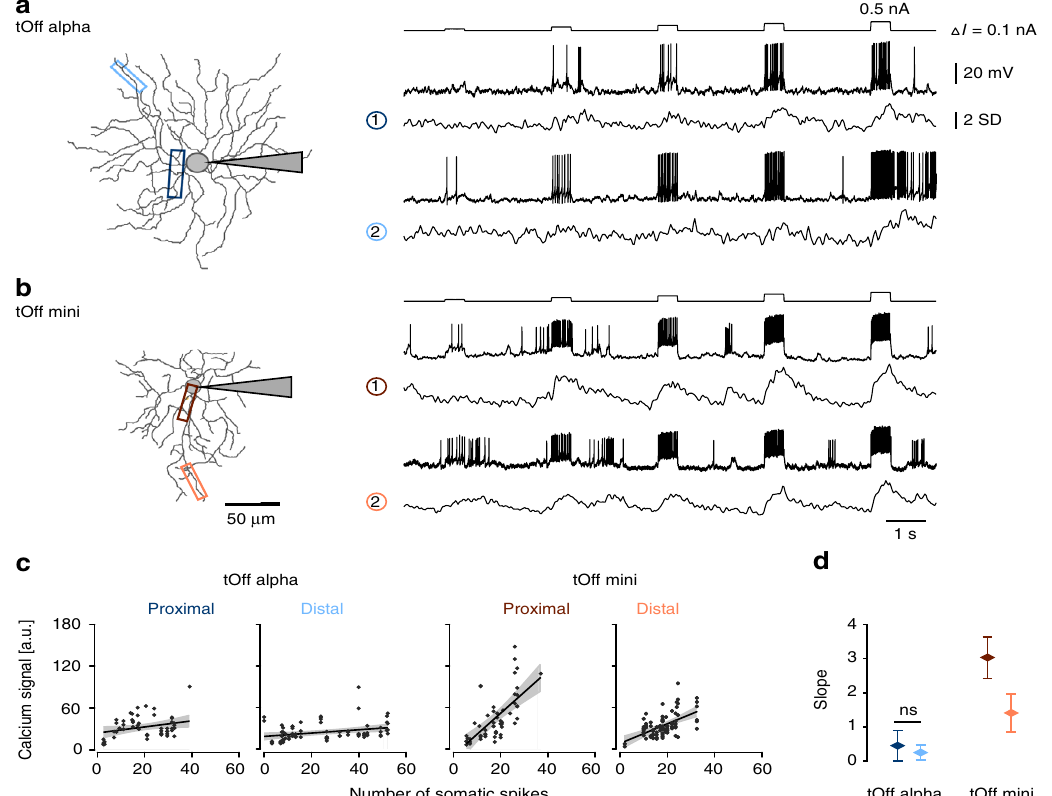
Fig. 6 Evaluating backpropagation using somatic current injections in tOff alpha and tOff mini cells. a Left: tOff alpha cell recorded electrically at the soma using whole-cell patch-clamp (shaded triangle represents electrode) while imaging dendritic Ca 2 + signals. Right: Simultaneously recorded somatic voltage and dendritic Ca 2 + signals in response to somatic 500-ms current injections (0.1 to 0.5 nA, Δ I = 0.1 nA); Ca 2 + signals from dendritic regions indicated by the boxes (left). b Same as in a , but for a tOff mini cell. c Dendritic Ca 2 + signal (as area under the curve) as a function of spike numbers generated in the soma (tOff alpha, n = 3\55\80 cells\ROIs for proximal dendrite\ROIs for distal dendrite; tOff mini, n = 3\55\80; linear regression and corresponding con fi dence interval shown as black line and grey shading, respectively). d Slope from the linear regression in c for proximal and distal dendrites and both RGC types (same colours as in a – c ). Data are presented as mean with error bars indicating 95% con fi dence intervals. Except for the slopes estimated based on for proximal and distal dendritic recordings in tOff alpha cells, all the slopes are signi fi cantly different across conditions (F(3, 267) = 27.357, p < 0.0001. Tukey ’ s method is used for post hoc pairwise comparison. For details, see text and Supplementary Statistical